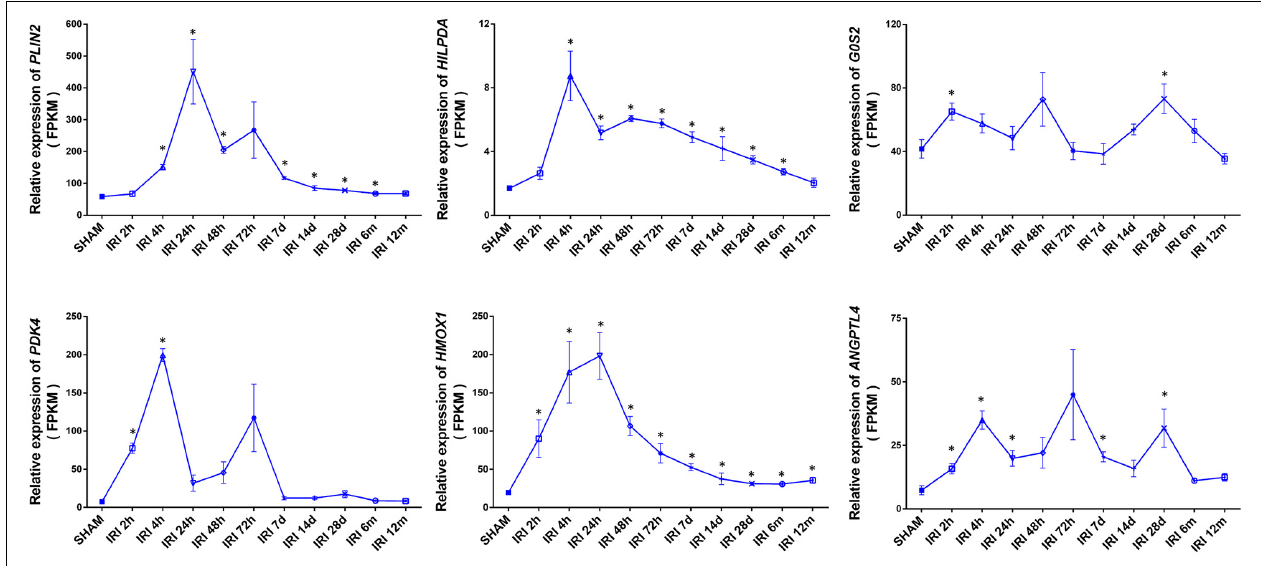
FIGURE 5 | Elevated expression of lipid metabolism genes at the whole-kidney level after acute kidney injury (AKI). Relative expression of the indicated genes is shown by FPKM. Data came from published RNA-seq profiles (GEO accession GSE98622). IRI: ischemia/reperfusion injury. SHAM: sham IRI surgery controls. X -axis ticks show different examination time points following IRI of respective groups. Values are expressed as the mean ± SEM (* p <